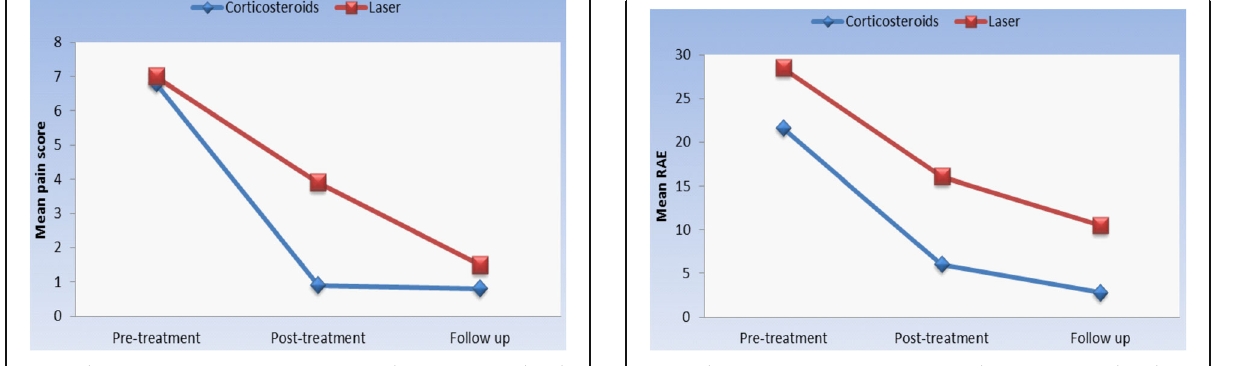
Fig. 2 Changes in mean RAE scores in the corticosteroid and laser